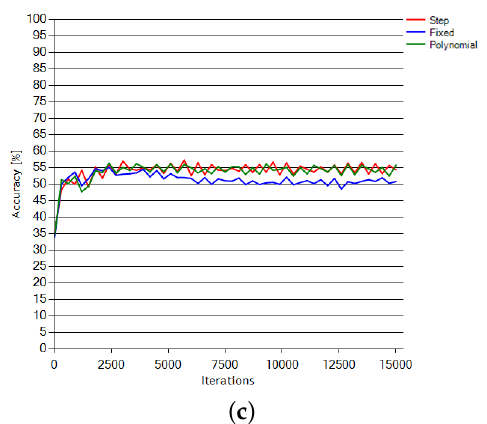
Figure 6. ( Top ) Accuracy change over iterations for Subjects 1 and 2 dataset training; and ( Bottom ) accuracy change over iterations for Subject 3 dataset training.